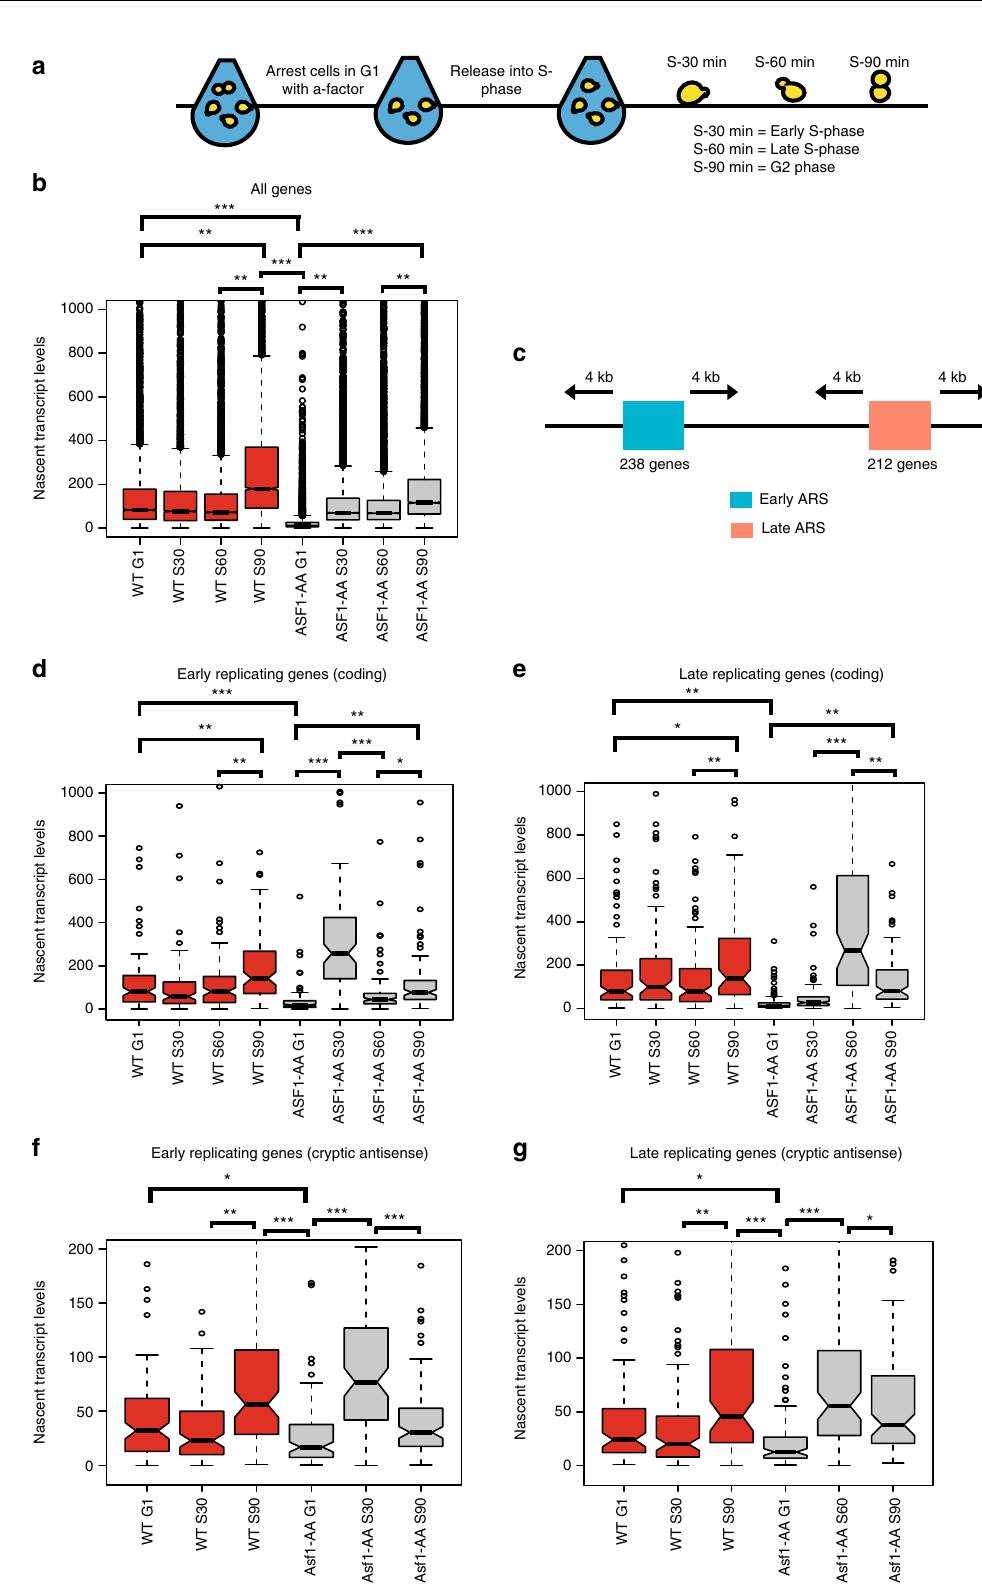
re fl ects productive buffering of early replicating genes, as expression of early replicating genes increased 1.7-fold as